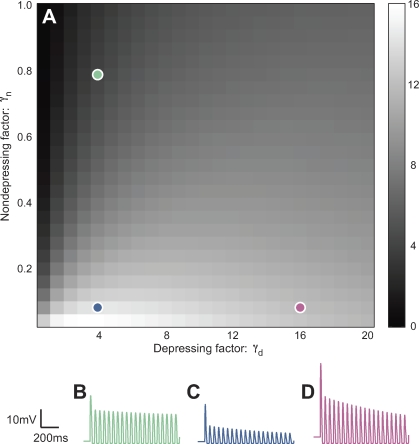
PSD Depression as a Function of Synaptic Factors and Exemplary Traces Used To Calculate This Measure(A) Measure of PSP depression (measured at the soma—a sum of all synaptic inputs) as a function of synaptic factors. Brighter shades of grey indicate more synaptic depression.(B–D) Exemplary traces of V
∞(t) in response to the initializing global synchronous oscillations at three positions in parameter space (indicated in (A) with dots of corresponding colors). This measure of PSP depression is identical to that used in previous studies of midbrain neurons in Eigenmannia [17–19]. Specifically, depression was quantified as the ratio (in decibels) of the peak value of V
∞(t) − V
0 in the first cycle of the initializing global synchronous stimulation to the average of the peak values for 11 consecutive cycles, starting 3 seconds into the stimulus.